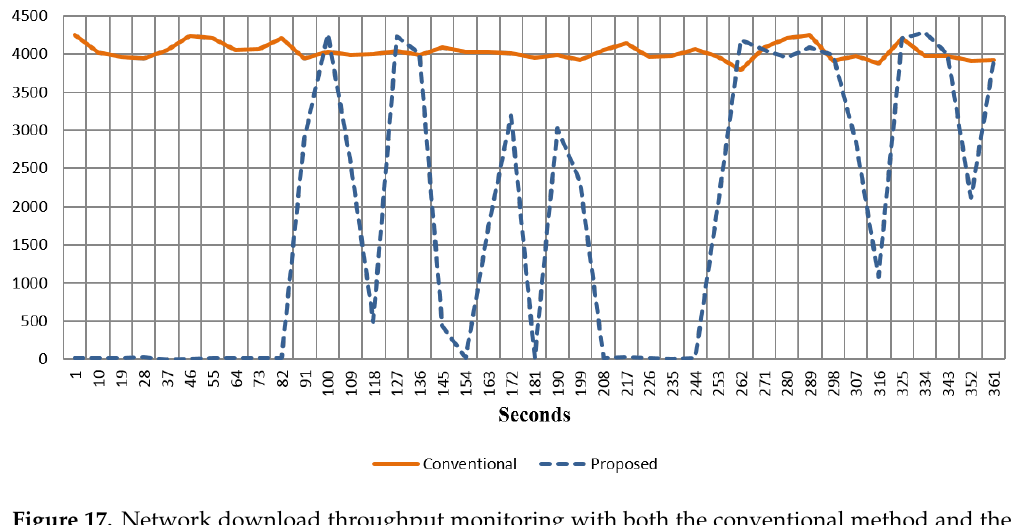
Figure 17. Network download throughput monitoring with both the conventional method and the proposed method. Table 6. Average computing resources of both the conventional method and the proposed